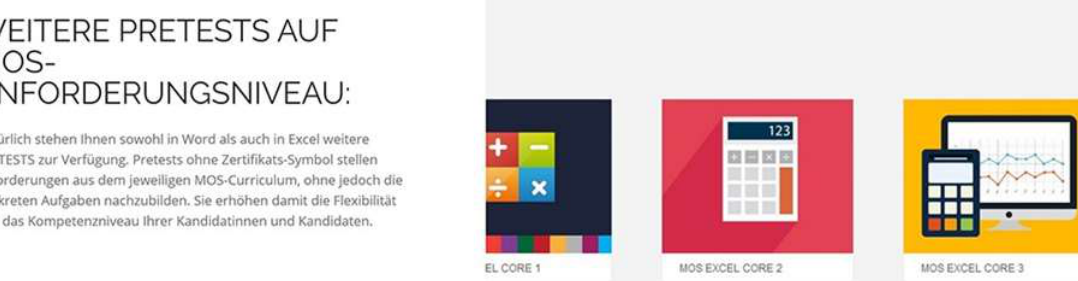
Figure 1 Practice tests for MOS certification (Source: teComp, 2020 5